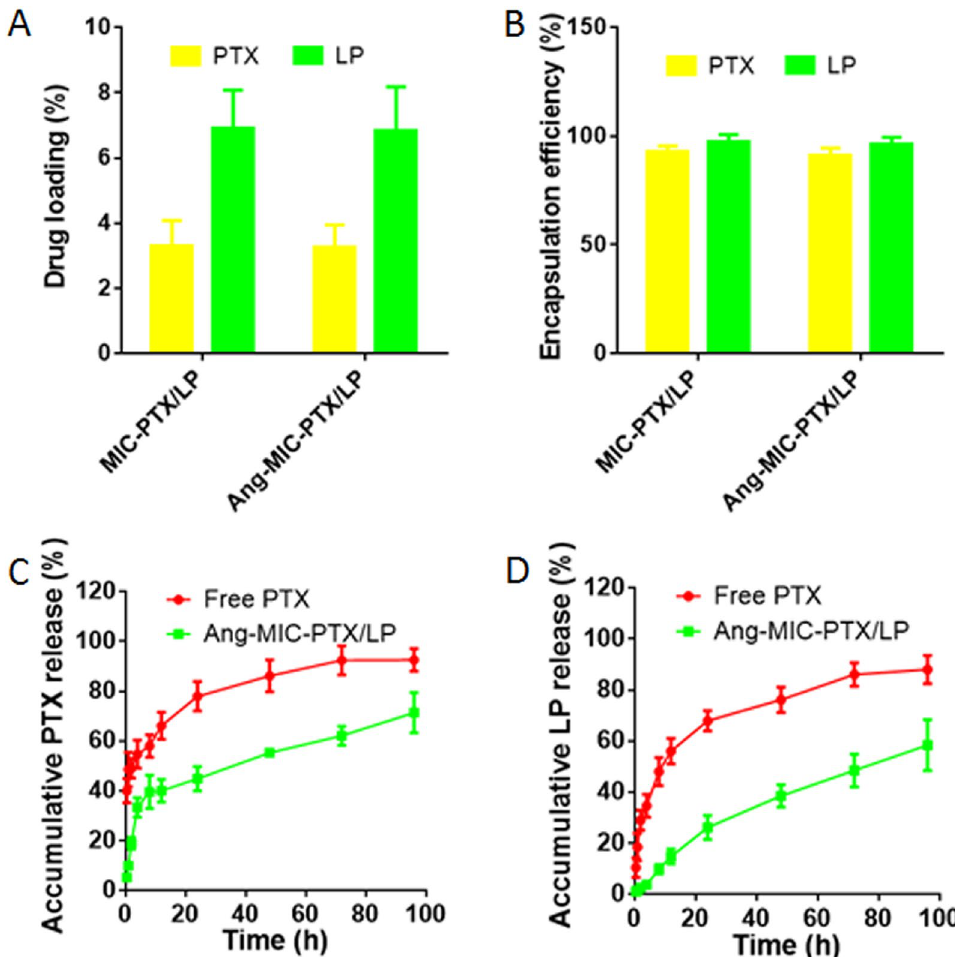
Figure 2. Drug loading capability and drug releasing profile of Ang-MIC-PTX/LP. ( A ) Drug loading of PTX and LP in MIC-PTX/LP and Ang-MIC-PTX/LP. ( B ) Encapsulation efficiency of PTX and LP in MIC-PTX/LP and Ang-MIC-PTX/LP. LP Released profile of ( C ) PTX and ( D ) from Ang-MIC-PTX/LP in 5% FBS containing 0.1% Tween 80 (n =